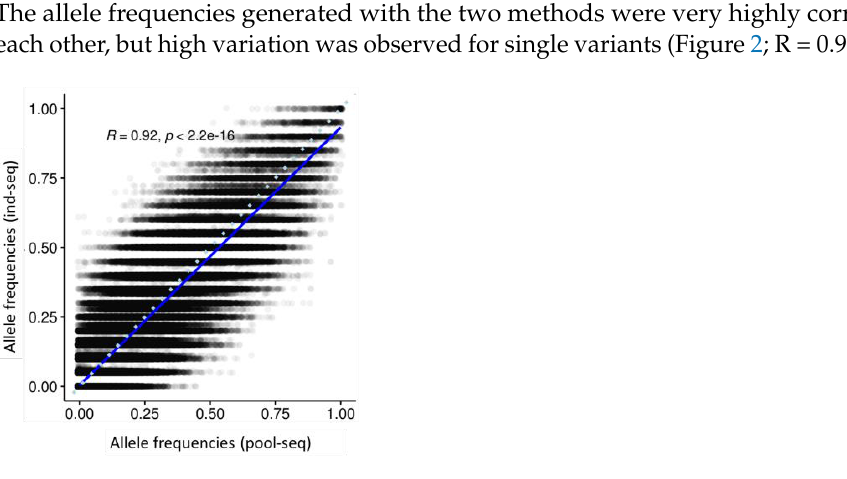
Figure 2. Allele frequency correlation between pool- and ind-seq in each